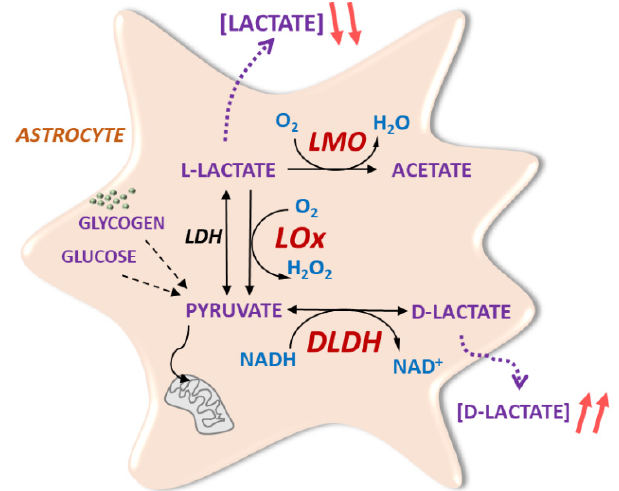
Figure 1. Novel molecular tools based on bacterial enzymes to modulate astrocytic lactate signalling. Astrocytic lactate dehydrogenase (LDH) converts pyruvate from glycolytic activity to lactate. Lactate is irreversibly oxidised by transgenic LMO of microbial origin to acetate, or to pyruvate by LOx (as previously described in [5]). This decreases the intracellular lactate pool and limits lactate release from astrocytes. Bacteria-derived DLDH reversibly catalyses the conversion of pyruvate into D-lactate, which is subsequently released from astrocytes.